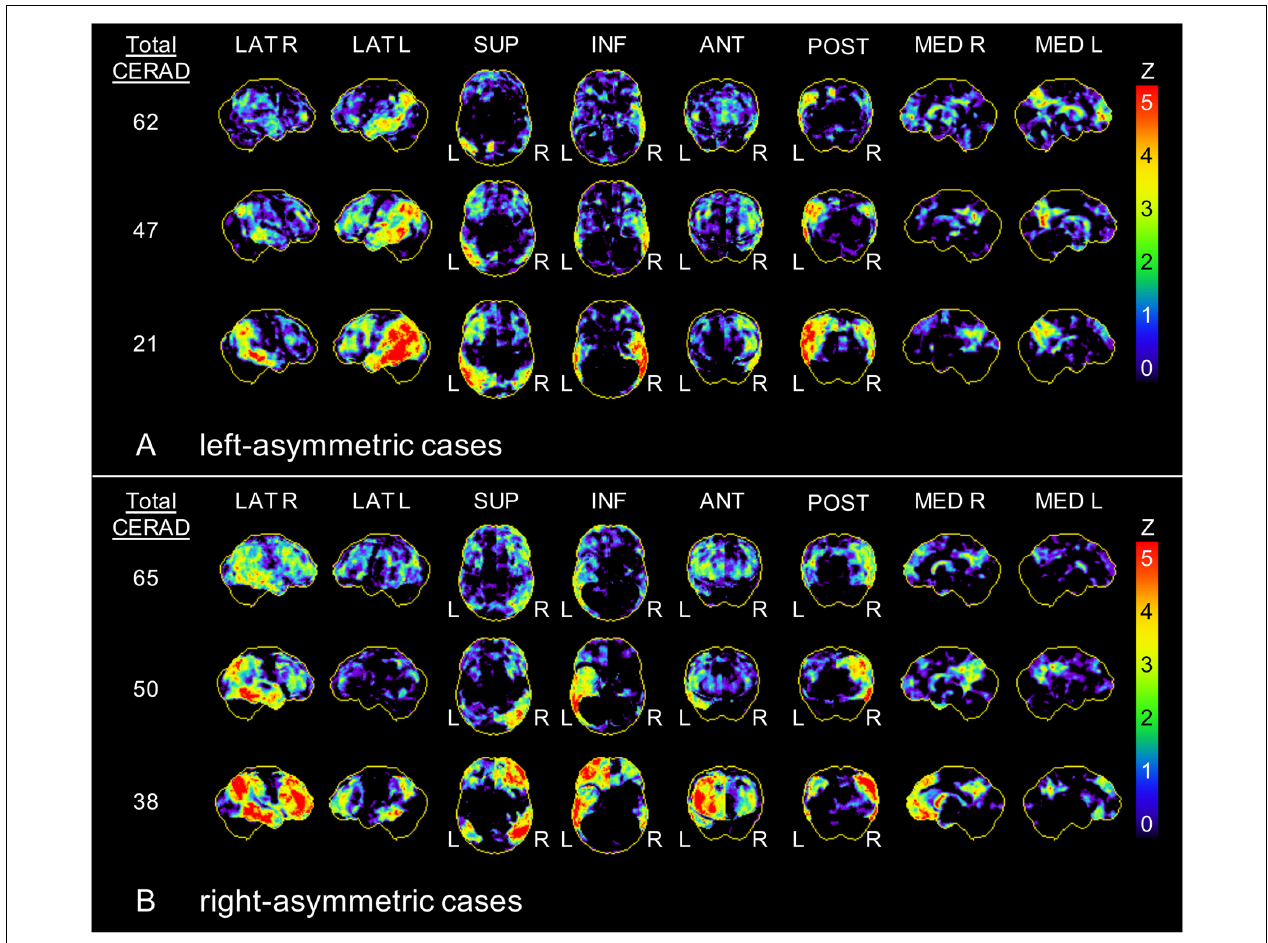
FIGURE 1 | Exemplary asymmetric hypometabolism patterns. Three-dimensional stereotactic surface projections ( Z -score maps) of patients with (A) left-asymmetric and (B) right-asymmetric hypometabolism in F-18-fluorodeoxyglucose positron emission tomography (FDG-PET). CERAD, Consortium to establish a registry for Alzheimer’s disease; R, right; L, left; LAT, lateral; SUP, superior; INF, inferior; ANT, anterior; POST, posterior; MED,